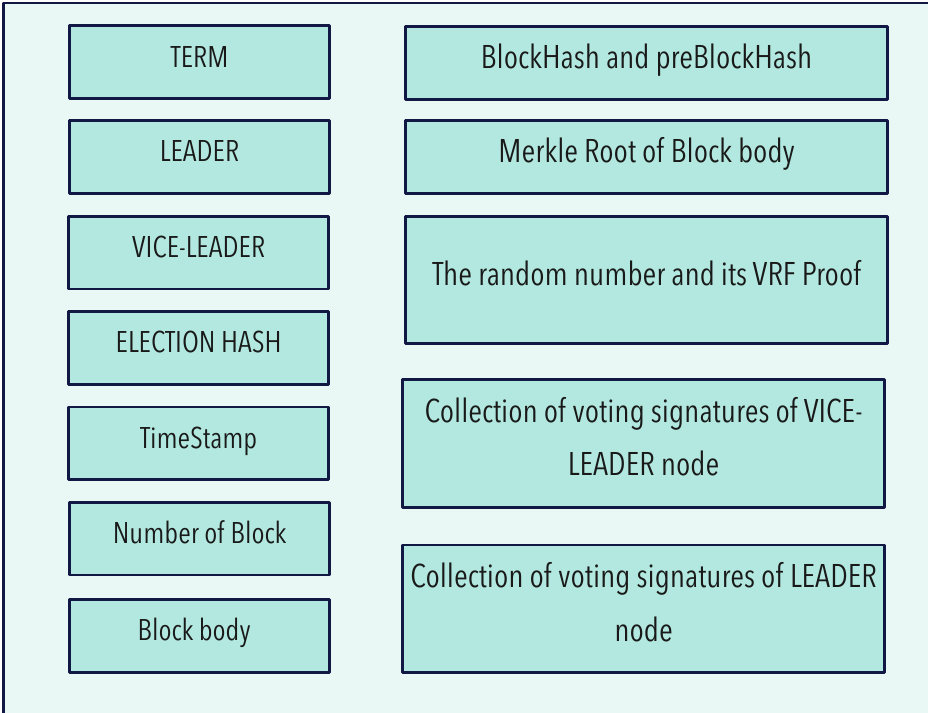
Figure 2. Data structure of the